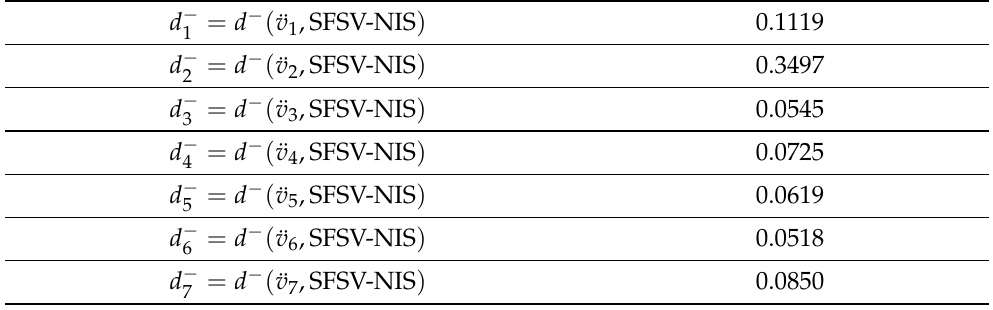
Table 19. Negative ideal solution.